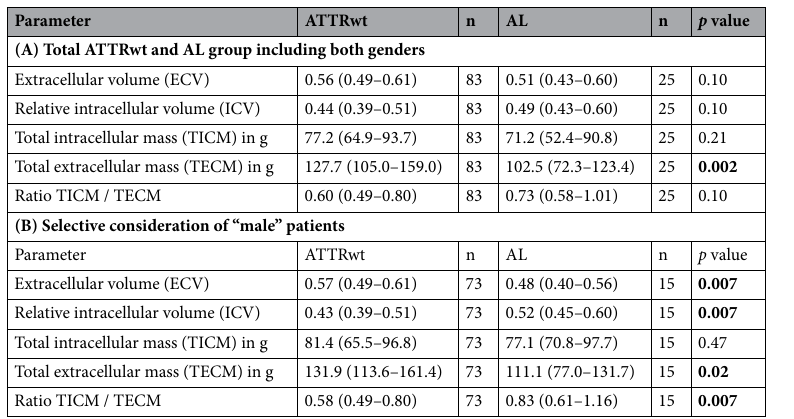
Table 2. Closer consideration of total intracellular and extracellular myocardial mass and their respective myocardial distribution ratio. Significant values are in bold.